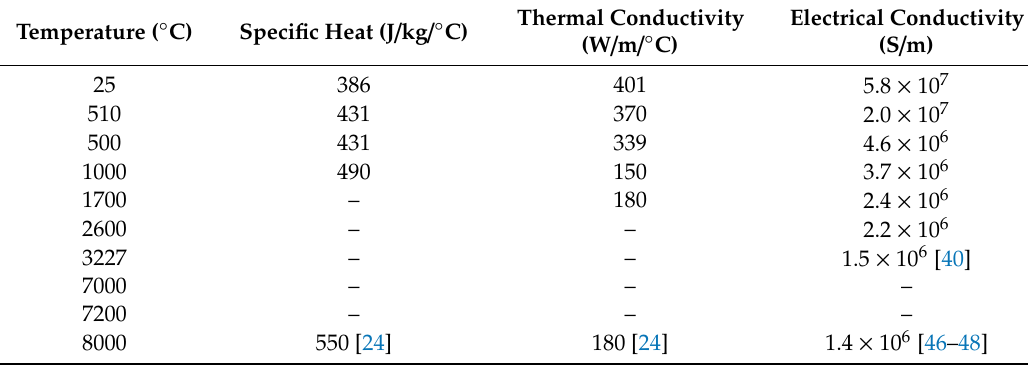
Table 4. Copper thermal and electrical material properties [24,40,46–48].